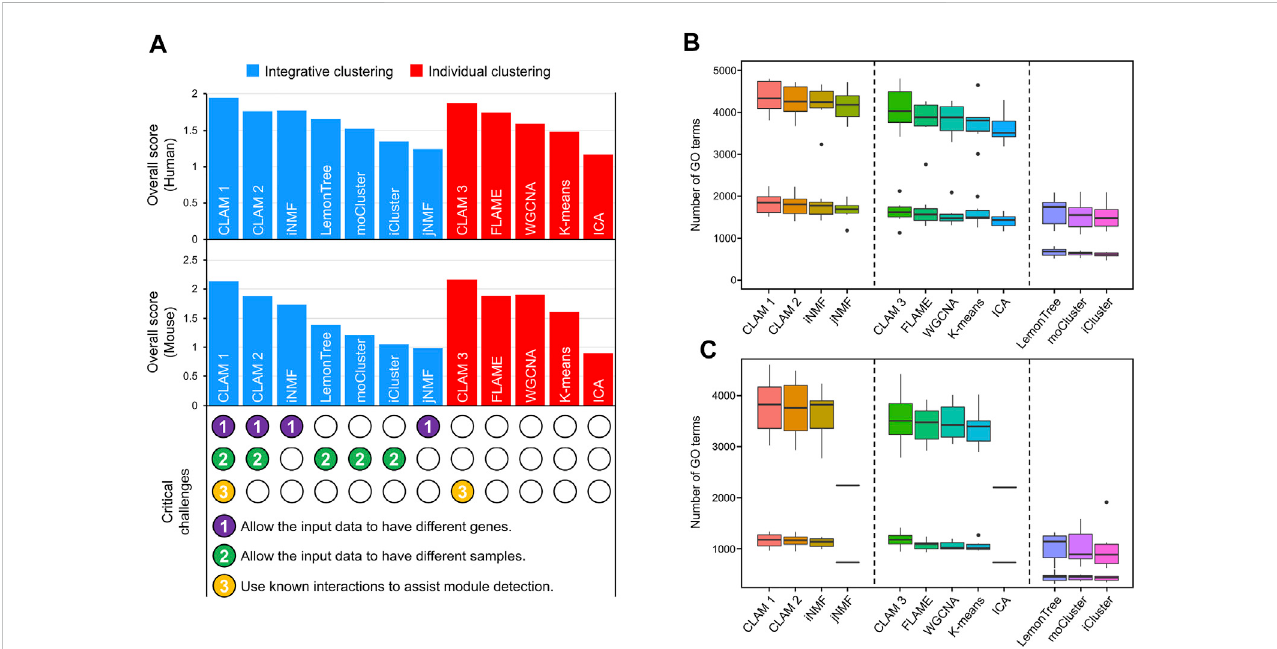
FIGURE 2 Comparison of 12 module detection methods, including 7 integrative clustering methods and 5 individual clustering methods. (A) The histograms show the agreement between the observed and known modules. Scores in the upper and middle histograms are generated by applying the tested methods to human and mouse data, respectively. The bottom shows whether the tested methods address three critical challenges of integrative clustering. (B – C) The number of signi fi cantly enriched GO terms in (B) human and (C) mouse modules with p -value thresholds of 0.01 and